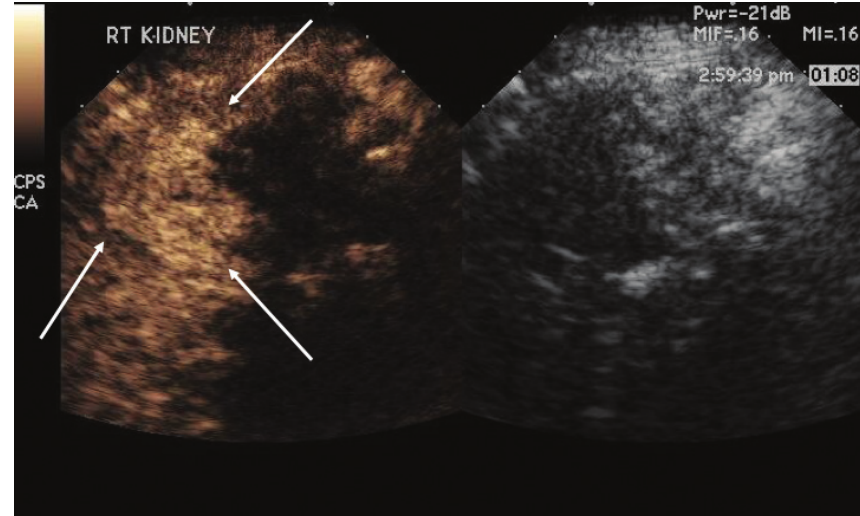
Figure 2. Multiple doses of ultrasound contrast can be administered during the RFA procedure. The contrast agents last for about 5 min so that residual enhancement is not present on additional doses. In this case, a CEUS study was performed after the first ablation. Note that there is residual tumor (arrows). The RFA needle can then be repositioned into the residual tumor for addi- tional ablation. This confirms that the tumor is completely ablated at the first setting. The similar process cannot be performed in CT because only one dose of CT contrast can be